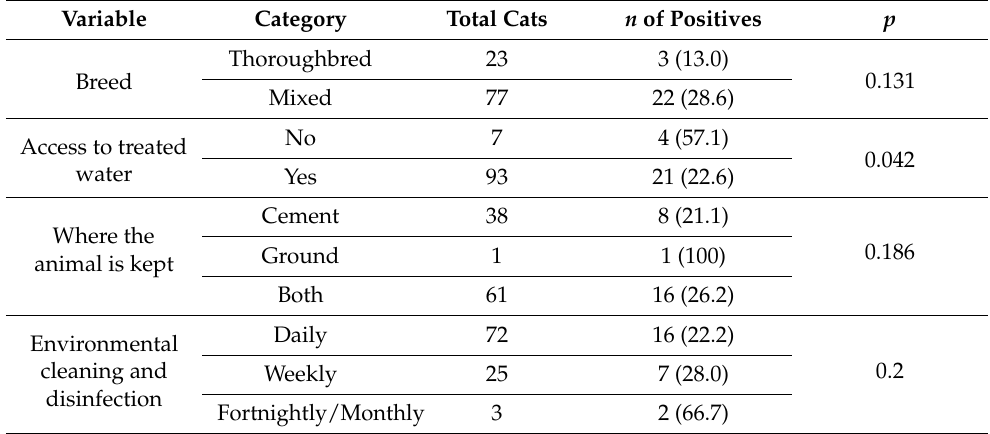
Table 2. Univariate analysis of risk factors associated with anti- Toxoplasma gondii antibodies positivity in cats ( n = 100) in the state of Rond ô nia, North